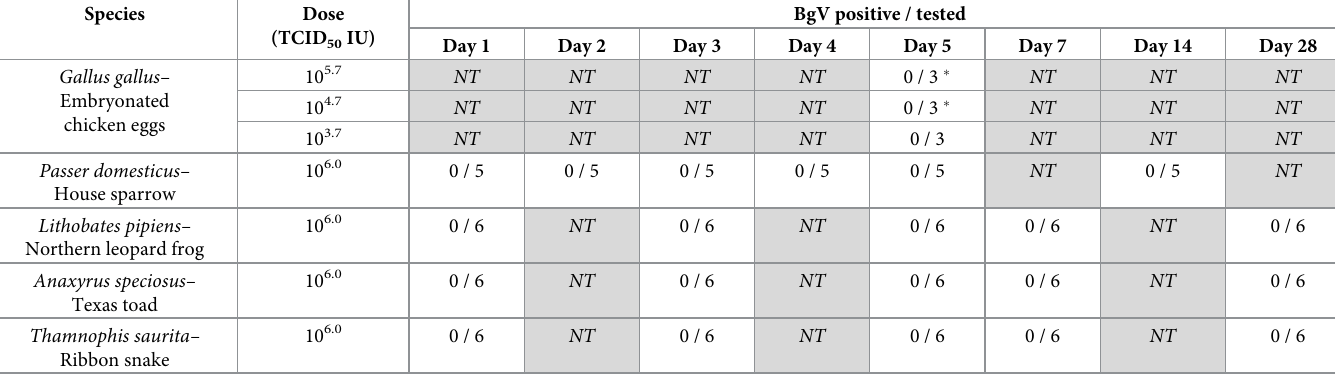
Table 2. BgV replication in vertebrate animal models. Groups of three eggs were inoculated with three doses of BgV intravenously (10 5.7 , 10 4.7 and 10 3.7 TCID 50 IU/egg, respectively), incubated at 33–35˚C for five days and homogenised. The homogenates were titrated on C6/36 cells and the resulting virus titres were analysed by fixed-cell ELISA. The eggs injected at the higher doses had traces of virus present but at levels suggesting they resulted from leftover inoculum rather than virus replication. The other animal models were inoculated with 10 6 TCID 50 IU of BgV and sampled for blood on days 1–5 and 14 post-inoculation (sparrows) or on days 1, 3, 5, 7, and 28 post- inoculation (frogs, toads, snakes). The blood samples were diluted 1:5 and 1:50 and inoculated on C6/36 cells which were incubated for two days and analysed for virus by fixed-cell